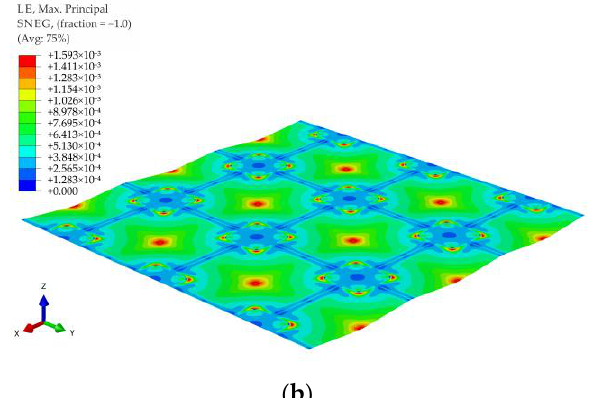
Figure 29. Deformation and maximum principal strain in reinforcement for pyramid shape load distribution, variant A2: ( a ) k = 0 kN/m 3 ; ( b ) k = 500 kN/m 3 .